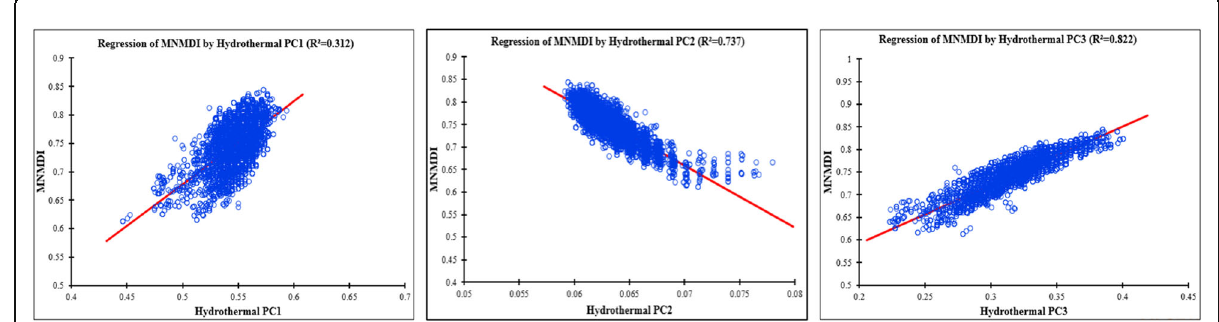
Fig. 16 Regression of MNMDI and Hydrothermal principal components